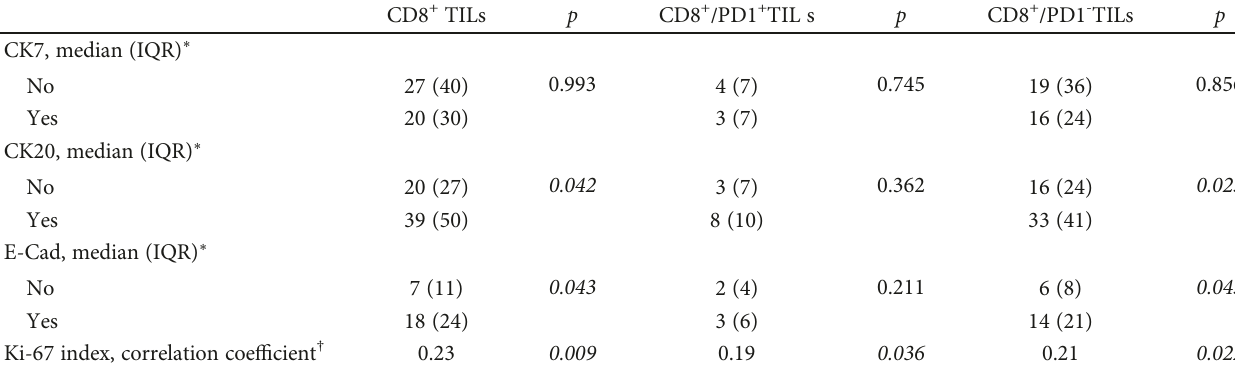
Table 5: Correlation between cell counts of CD8/PD-1 TILs and other molecules in breast